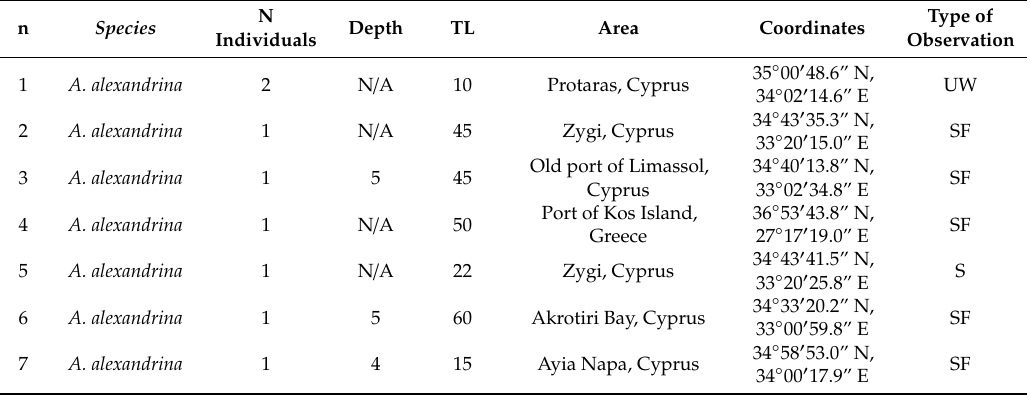
Figure 1. ( A,B ): Alectis alexandrina juvenile sighted in Protaras, Cyprus; ( B,C ): Alectis alexandrina adults caught in Zygi and Limassol port (Cyprus) respectively; ( D ): Alectis alexandrina adult captured in the harbour of Kos Island, Greece; ( E ): Alectis alexandrina juvenile sighted in Zygi, Cyprus; ( F ): Alectis alexandrina captured by spearfishing in Akrotiri Bay, Cyprus; ( G,H ): Ranzania laevis individual captured with surface longline in Psathoura Island, Greece. Table 1. Records of five rare species in the eastern Mediterranean Sea with information on number of individuals (N), depth (m.), total length (cm.), area, coordinates (lat: lon) in decimal degrees and type of observation (underwater, UW; shore fishing, SF; spearfishing,; demersal longline, LL; Otter bottom trawl